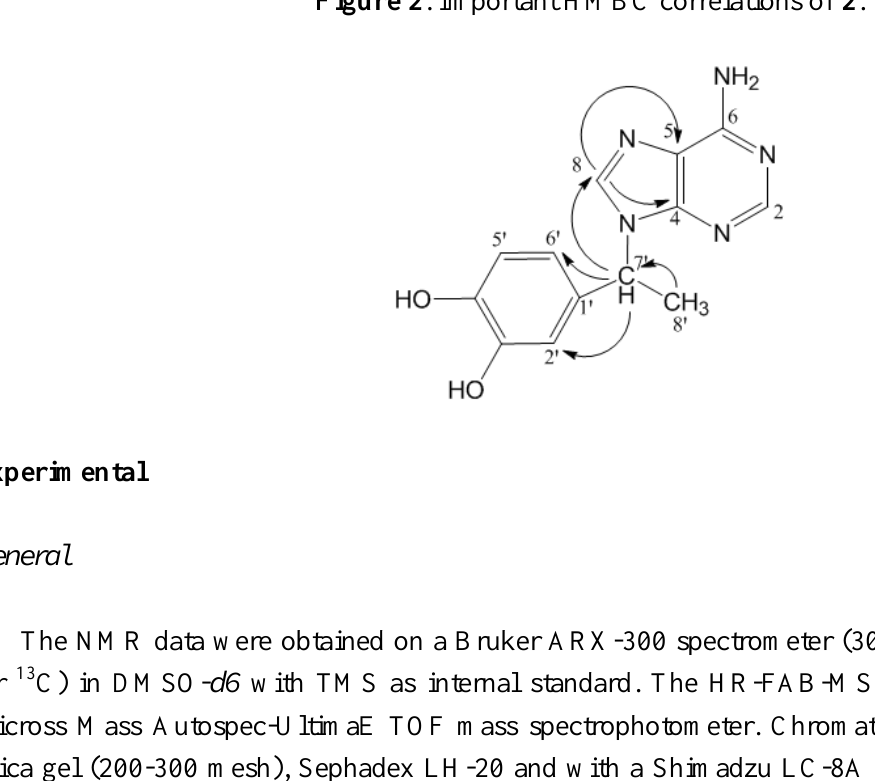
Figure 2 . Important HMBC correlations of 2